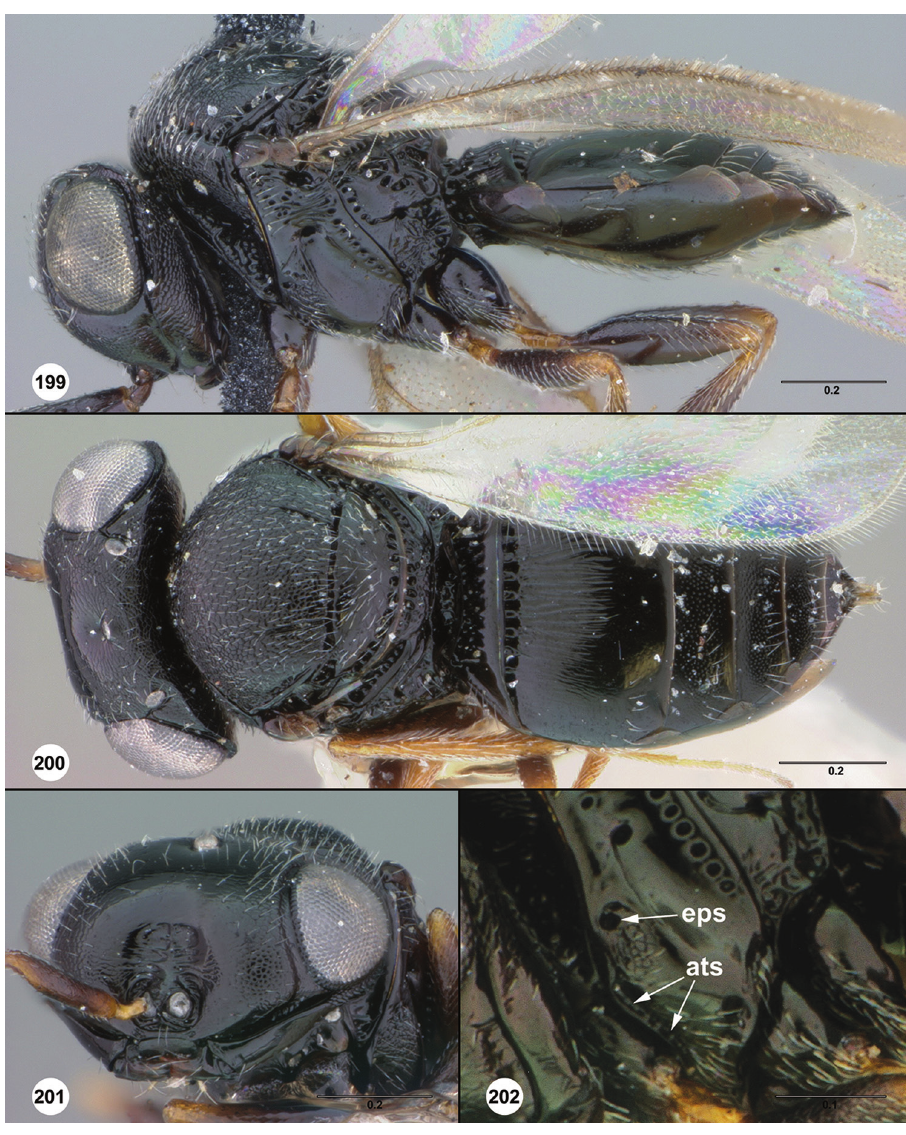
Figures 199–202. Trissolcus tumidus 199 female holotype (NHMW 0002), head, mesosoma, metaso- ma, lateral view 200 female holotype of T. cephalotes syn. n. (ZMAS 0142), head, mesosoma, metasoma, dorsal view 201 female holotype of T. cephalotes syn. n. (ZMAS 0142), head, anterior view 202 female (USNMENT00979425), mesopleuron, lateral view. Scale bars in millimeters. ocellar pit: microsculptured. Macrosculpture of lateral frons: absent. OOL: separated by less than one ocellar diameter. Hyperoccipital carina: effaced medially. Macroscu- lpture of posterior vertex: absent. Microsculpture on posterior vertex along occipital carina: present. Anterior margin of occipital carina: coarsely